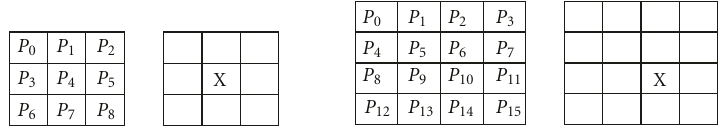
Figure 1: The 3 × 3 and 4 × 4 templates with symbol X denoting the estimated pixel, respectively.